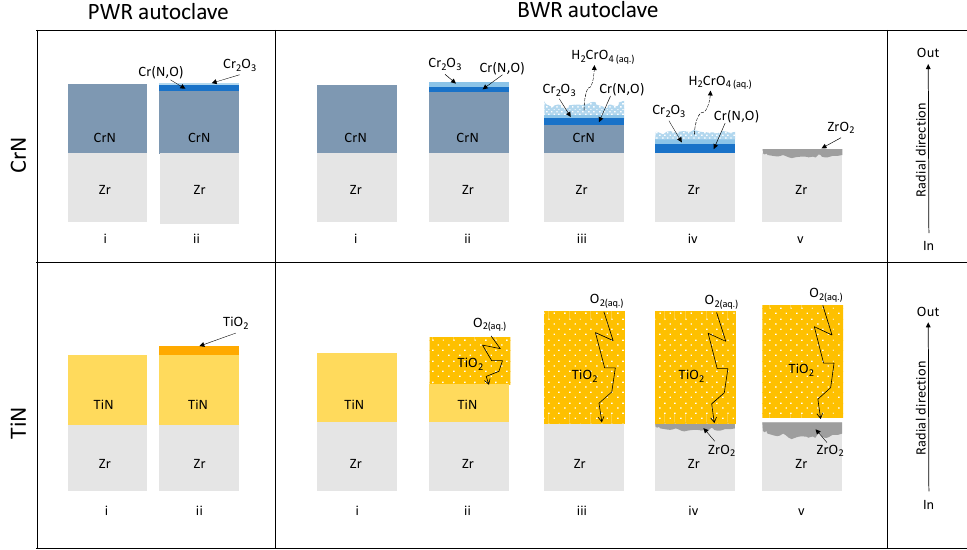
Figure 3. Schematic of the proposed corrosion mechanisms for CrN and TiN in the PWR autoclave and BWR autoclave environments.